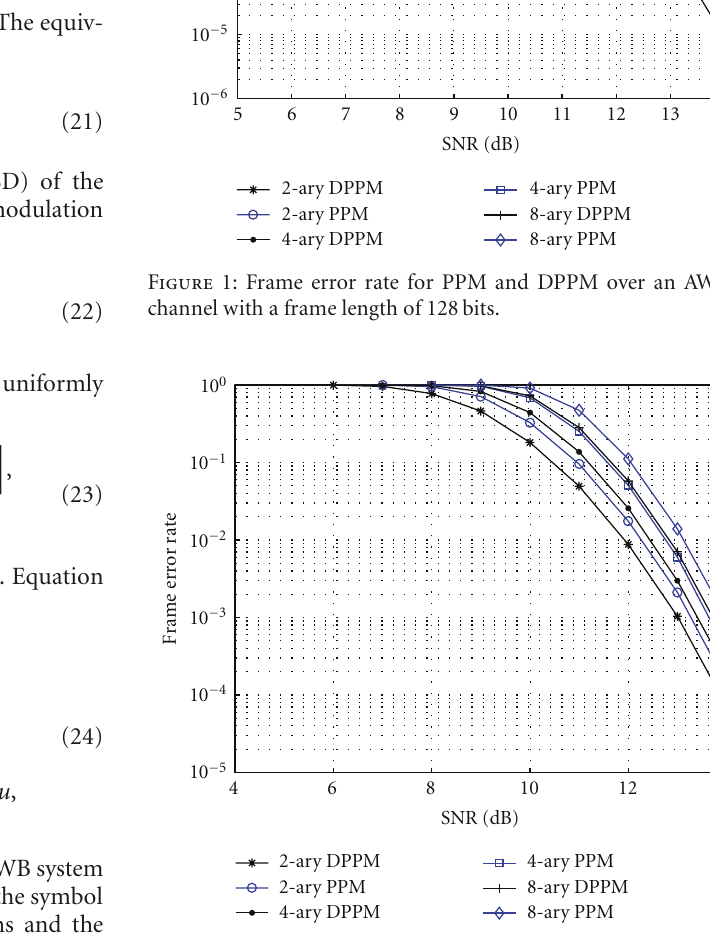
Figure 2: Frame error rate for PPM and DPPM over an AWGN channel with a frame length of